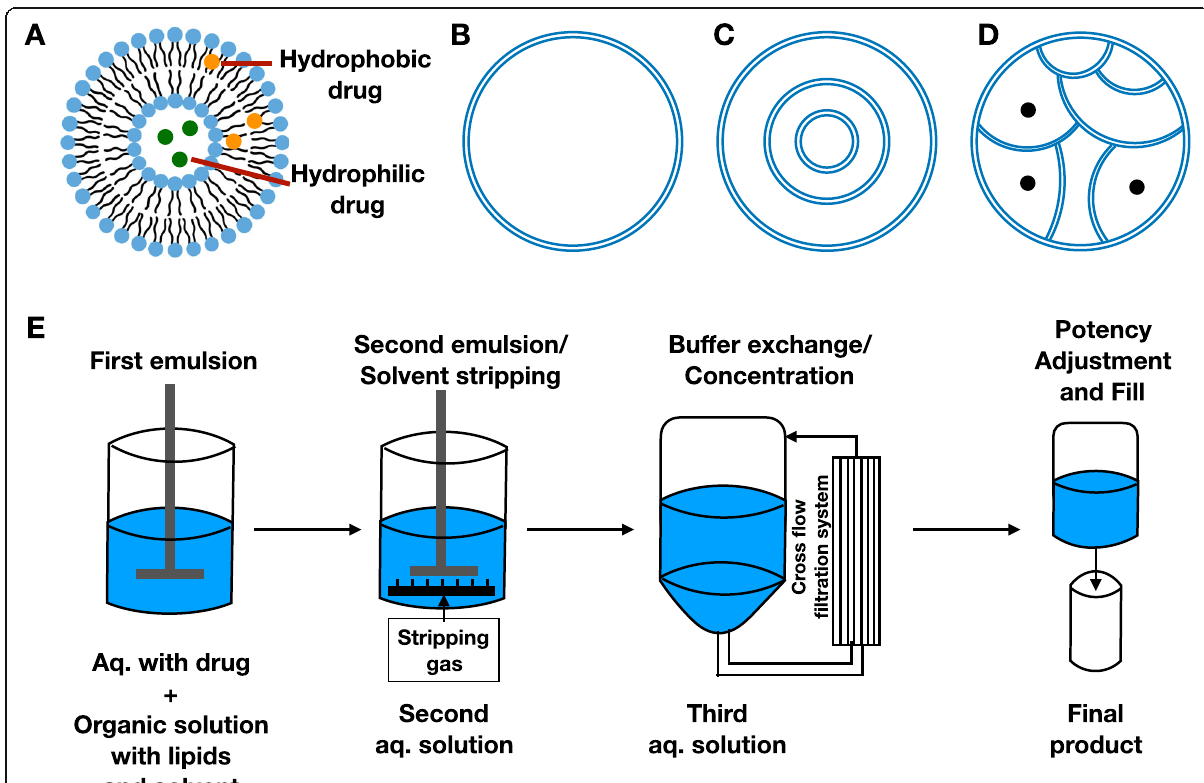
Fig. 4 Structural characteristics of different liposomes. a Drug distribution in liposomes. b Uni-lamellar liposome. c Multi-lamellar liposome. d Multi-vesicular liposome. e Demonstration of DepoFoam